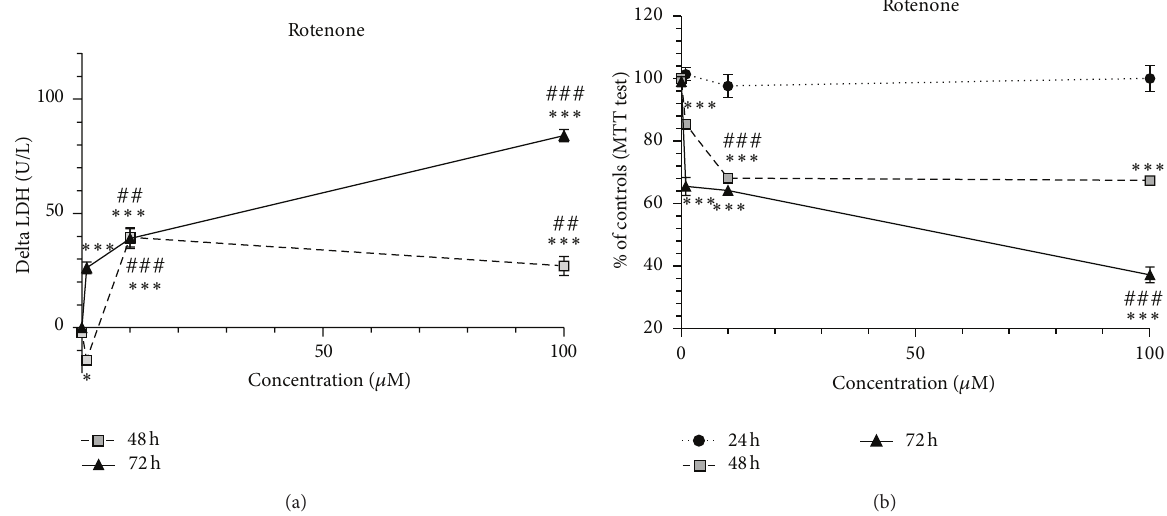
Figure 3: ROT-induced neurotoxicity showed a biphasic pattern with mitochondrial dysfunction and cell death in differentiated SH-SY5Y cells. The cells were incubated with 1, 10, and 100 𝜇 M of ROT, and then MTT and LDH tests were performed at 24, 48, and 72h time points. (a) Increase in LDH release in units per liter (U/L) into the medium in differentiated SH-SY5Y cells. The delta increase in LDH release into the medium was calculated by subtraction of the respective controls (results were pooled from 3 different experiments, each experiment having 6 different culture wells per condition). (b) Mitochondrial dysfunction in differentiated SH-SY5Y cells evaluated by the MTT test. The viability of untreated control cells was set to 100%, and all treatments were expressed as the percentage of the respective controls (results were pooled from 3 different experiments, each experiment having 6 different culture wells per condition). The means were compared using the two-way ANOVA, followed by the Bonferroni post hoc test ( ∗∗∗ 𝑃 < 0.001 concentration versus control; ## 𝑃 < 0.01 , ### 𝑃 < 0.001 concentration versus